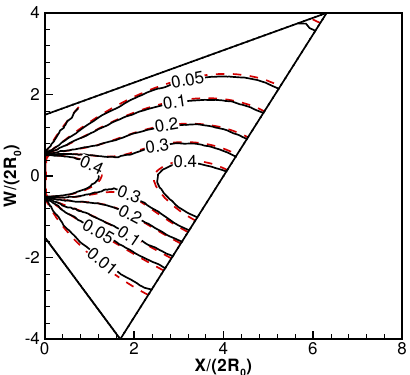
Figure 16. Pressure contours for free jet impingement on an inclined specular rectangular reflective plate, from a round exit, in the middle vertical plane. Results normalized by the static pressure at the nozzle exit. Dashed: analytical; solid: